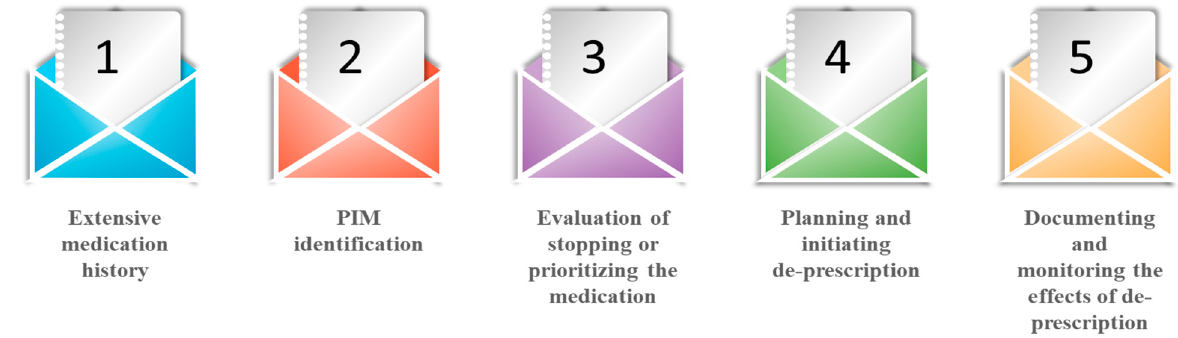
Figure 2. Deprescription process.